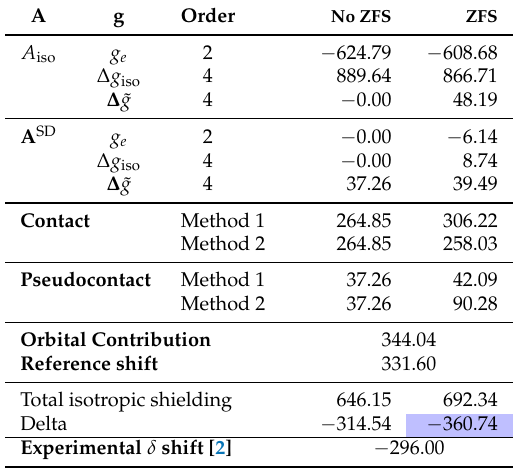
Figure 8. ( a ) Chemical structure of U(N(SiMe t Bu 2 ) 2 ) 3 , ( b ) Stereochemistry of U(N(SiMe t Bu 2 ) 2 ) 3 with uranium and silicon nuclei shown as spheres and the remaining non-hydrogen nuclei in wireframe. Stated distances are in Angstroms. Table 11. Calculated 29 Si pNMR shifts of U(N(SiMe t Bu 2 ) 2 ) 3 in ppm at 298 K. The final, ZFS corrected, computational values are